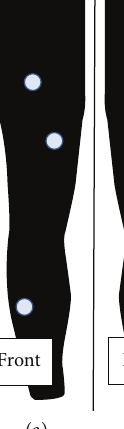
Figure 3: Reflective markers were placed on the hip, knee, ankle, heel, and toe (modified) to calculate the heel contact. In addition, EMG sensors were located on the right rectus femoris, tibialis anterior, lateral gastrocnemius, soleus, vastus medialis, and biceps femoris, and two workout wraps were used to stabilize the EMG sensors during faster gait speed. The subjects were instructed to hold the safety bar installed on the treadmill to avoid excessive anterior- posterior